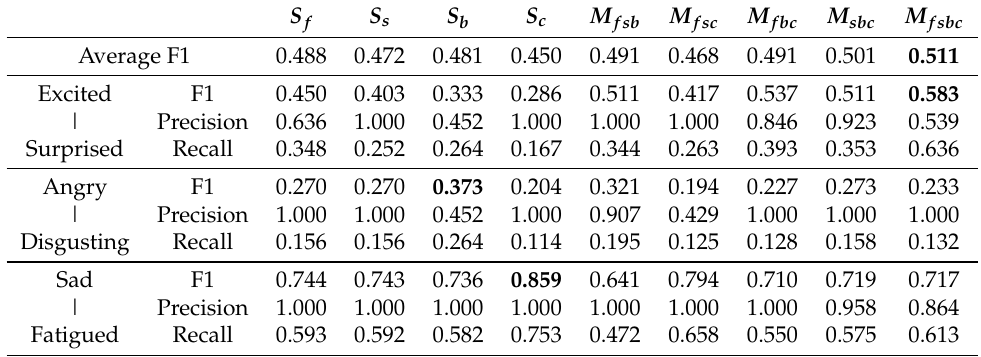
Table 9. Performance of driver emotion recognition among inducible emotions of Driver